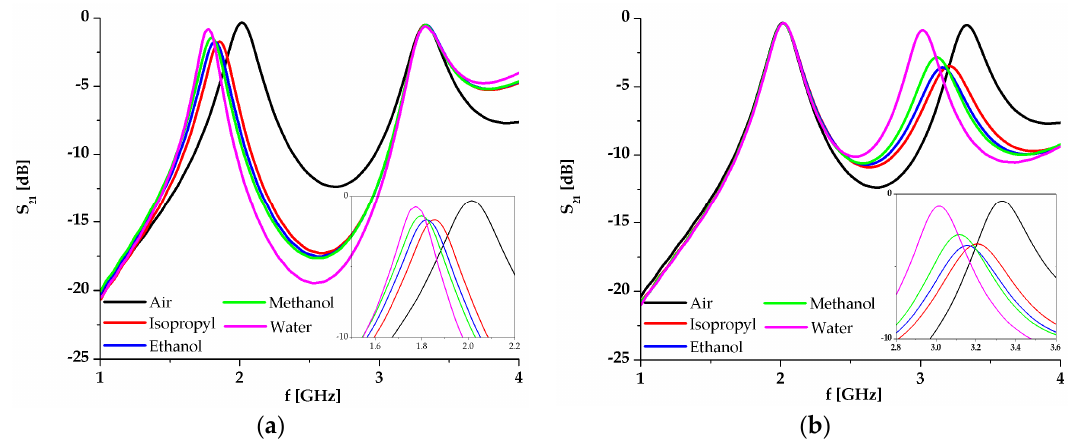
Figure 5. ( a ) Simulation results of the proposed sensor with different fluids placed in channel 1, whilst channel 2 is filled with air; ( b ) Simulation results of the proposed sensor with different fluids placed in channel 2, whilst channel 1 is filled with air.